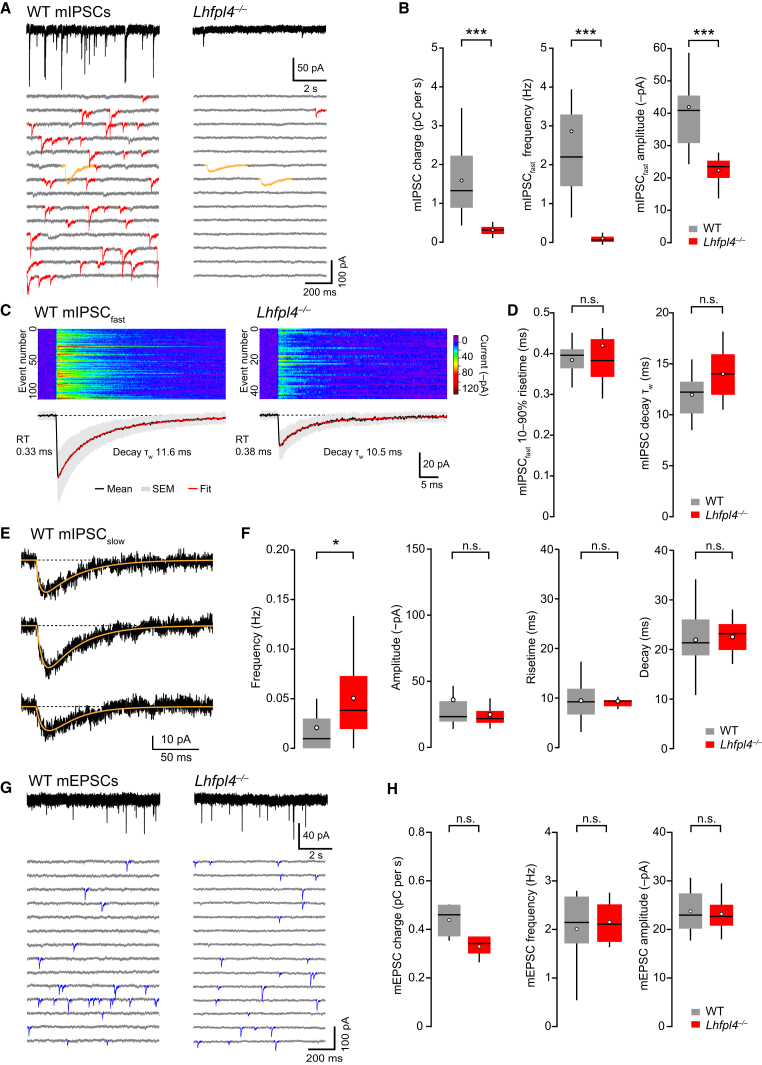
Loss of Fast mIPSCs in CA1 Pyramidal Neurons from Lhfpl4−/− Mice(A) Representative recordings of mIPSCs (−70 mV) in CA1 pyramidal cells from a WT mouse (left) and an Lhfpl4−/− mouse (right). Lower panels are representative sections of recordings (contiguous 1-s segments) showing a loss of fast mIPSCs (red) but a maintained presence of slow mIPSCs (orange). Records are digitally filtered at 2 kHz for illustration purposes.(B) Pooled data showing reduction in mean mIPSC charge transfer (from 1.59 pC ± 0.21 pC to 0.31 pC ± 0.11 pC; n = 18 WT and 18 Lhfpl4−/− cells), frequency (from 2.86 Hz ± 0.54 Hz to 0.10 Hz ± 0.03 Hz; n = 18 WT and 18 Lhfpl4−/− cells), and amplitude (from 141.9 pA ± 3.8 pA to 22.3 pA ± 1.1 pA; n = 18 WT and 14 Lhfpl4−/− cells). All p < 0.0001, Wilcoxon rank-sum test.(C) Top: images illustrating the alignment and amplitudes of selected mIPSCs with uncontaminated rise and decay from representative WT and Lhfpl4−/− recordings. Bottom: average mIPSC waveforms (black), SEM (gray), and fitted sum of exponentials (red). The 10%–90% rise times and weighted time constant of decay (τw) are shown for each representative record.(D) Pooled data showing the lack of effect on mIPSC rise time (0.38 ms ± 0.01 ms and 0.42 ms ± 0.04 ms; n = 18 WT and 11 Lhfpl4−/− cells; p = 0.86, Wilcoxon rank-sum test) and decay (12.0 ms ± 0.5 ms and 14.0 ms ± 1.4 ms; n = 18 WT and 11 Lhfpl4−/− cells; p = 0.20, Welch t test).(E) Representative slow mIPSCs (−70 mV) from CA1 pyramidal neurons (three different WT mice). Orange lines indicate fits of an empirical equation (see the Supplemental Experimental Procedures) from which 10%–90% rise time and 63% decay time measures were taken.(F) Pooled data showing the modest increase in frequency of slow mIPSCs in Lhfpl4−/− mice (from 0.021 Hz ± 0.007 Hz to 0.051 Hz ± 0.01 Hz; n = 18 WT and 18 Lhfpl4−/− cells; p = 0.014, Wilcoxon rank-sum test) but a lack of change in amplitude (36.0 pA ± 8.4 pA and 24.8 pA ± 2.4 pA; n = 12 WT and 16 Lhfpl4−/− cells; p = 0.37 Wilcoxon rank-sum test), rise time (9.5 ms ± 1.1 ms and 9.4 ms ± 0.4 ms; n = 12 WT and 16 Lhfpl4−/− cells; p = 0.77, Welch t test), and decay (21.9 ms ± 1.7 ms and 22.5 ms ± 0.9 ms; n = 12 WT and 16 Lhfpl4−/− cells; p = 0.93, Welch t test). Box-and-whisker plots indicate median (line), 25th–75th percentiles (box), the range of data within 1.5 × IQR of the box (whiskers), and mean (open circles).(G) Representative recordings of mEPSCs (−70 mV) in CA1 pyramidal cells from a WT mouse (left) and a Lhfpl4−/− mouse (right). Lower panels are representative sections of recordings (as in A), with mEPSCs in blue.(H) Pooled data showing no change in mean mEPSC charge transfer (0.44 pC ± 0.07 pC and 0.33 pC ± 0.03 pC), frequency (2.01 Hz ± 0.35 Hz and 2.15 Hz ± 0.27 Hz), and amplitude (23.7 pA ± 2.1 pA and 23.2 pA ± 2.4 pA). In each case, n = 6 WT and 4 Lhfpl4−/− cells (p = 0.21, 0.75, and 0.87, respectively; Welch t test).See also the Supplemental Experimental Procedures.